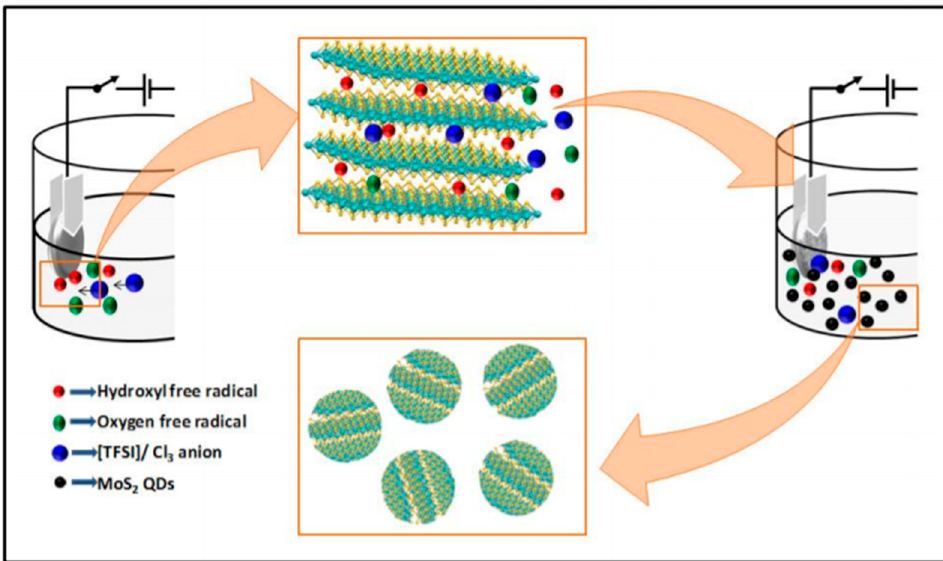
Figure 11. A schematic representation of the electrochemical exfoliation of MoS 2 pellets in LiTFSI/[BMIm]Cl-based aqueous electrolyte. Generated hydroxyl and oxygen free radicals trigger the initial cleavage of MoS 2 sheets. As time progresses, the MoS 2 anode swells by the incorporation of TFSI − anions and MoS 2 QDs dissolve in the electrolyte. Reproduced with permission from [44]. Copyright The Royal Society of Chemistry, 2015.